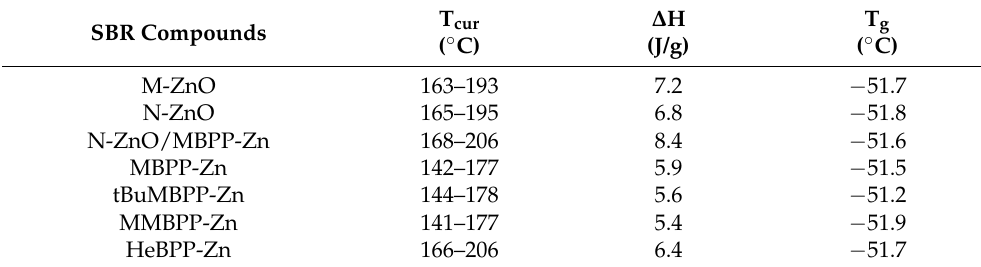
Table 4. Temperature and enthalpy of curing determined by differential scanning calorimetry (DSC) for SBR compounds containing ZnO and zinc complexes with 1,3-diketones as activators (T cur , curing temperature; ∆ H, curing enthalpy; T g , glass transition temperature; SD: temperature ± 9.0 ◦ C; ◦ ∆ H ± 2.6 J/g; T g ± 1